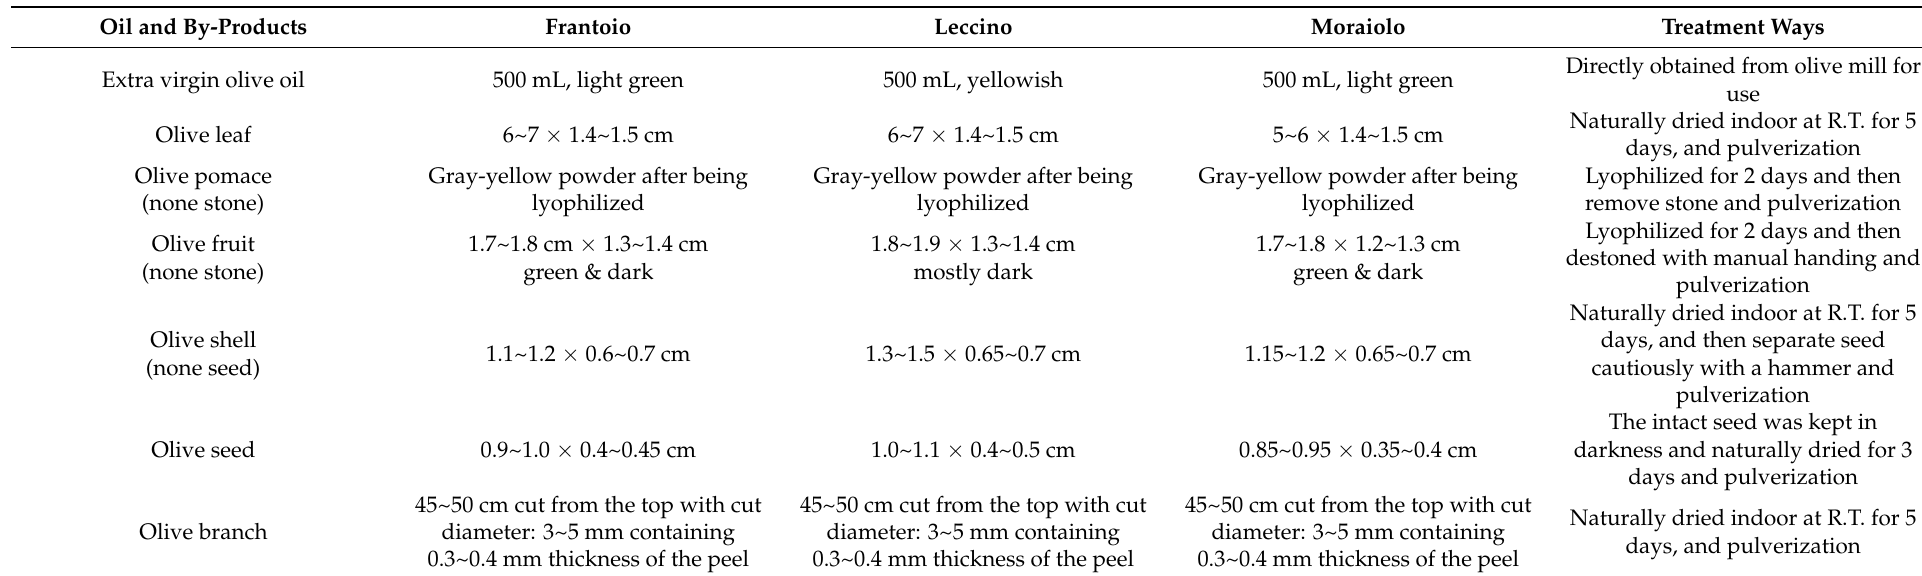
Table 1. Description of the selected samples from the three